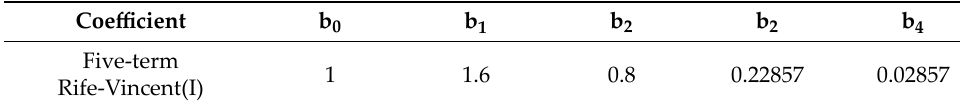
Table 2. The sidelobe properties of window functions. Sidelobe Normalized Peak Sidelobe Window Function Attenuation Rate Main‑Lobe Width Level [dB] [dB/oct] Rectangular 4 π /N − 13 6 Triangle 8 π /N − 25 12 Hanning 8 π /N − 31 18 Hamming 8 π /N − 41 6 Blackman 12 π /N − 57 18 Blackman‑Harris 16 π /N − 92 6 Five‑term Rife‑Vincent(I) 20 π /N − 78